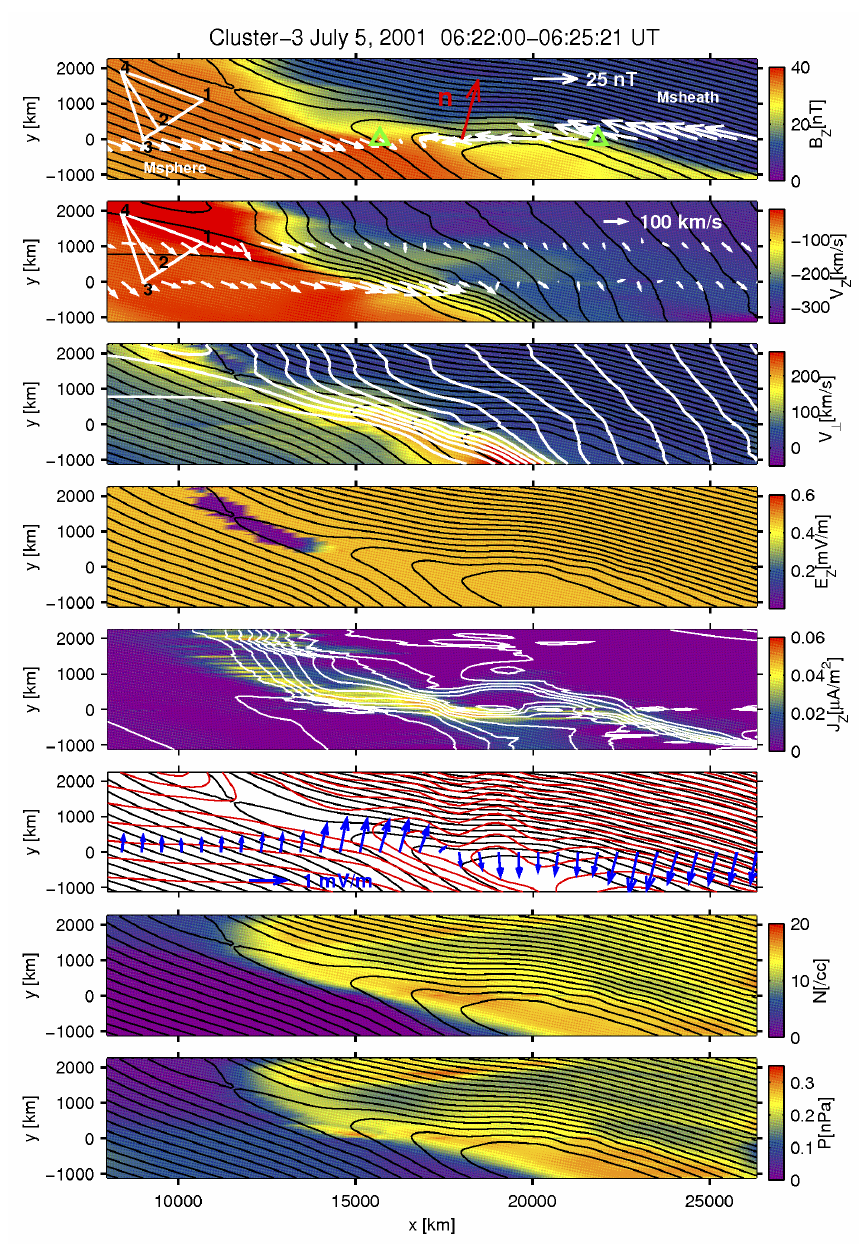
Fig. 6. MHD reconstruction results for the C3 magnetopause crossing on 5 July 2001. The first two panels show a portion of the magnetic field and streamline maps, with the axial magnetic field and axial velocity in color. The third panel is an overlay of magnetic field lines (black) and streamlines (white) with the magnitude of the transverse velocity, | v ⊥ | , in color. The fourth panel shows the magnetic field lines with the strength of the axial convection electric field in color. The fifth panel shows the in-plane current lines with axial current density in color. The sixth panel shows an overlay of electric equipotentials (red) and magnetic field lines (black), with the in-plane convection electric fields at y =0 denoted by blue arrows. The last two panels show the magnetic field map with the ion density and pressure in color. Magnetosphere (magnetosheath) is in lower left (upper right) of the map; sunward/northward is to the right.